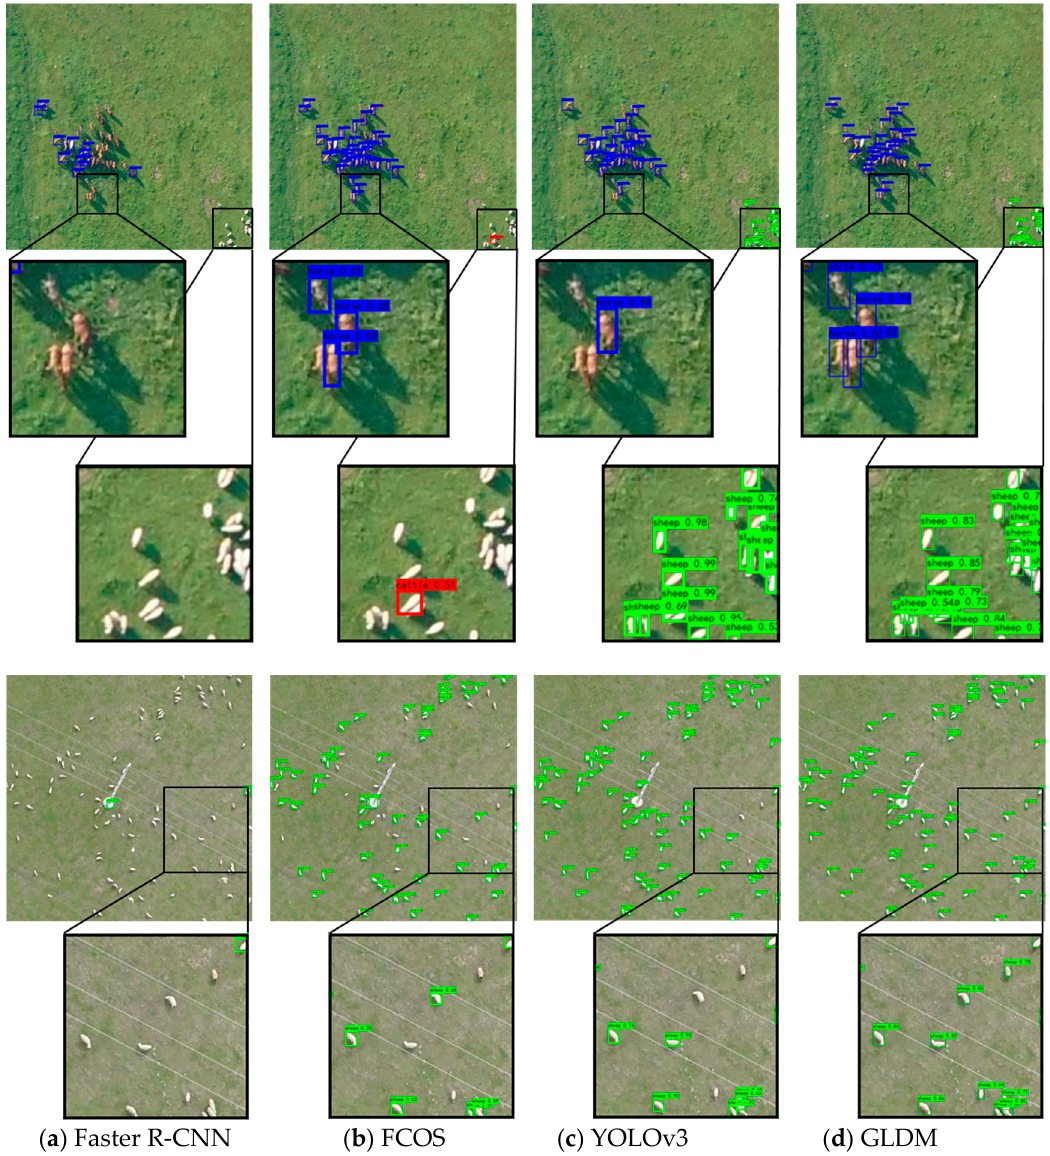
Figure 12. Visualization of the detection results for different methods. ( a ) Faster R-CNN; ( b ) FCOS; ( c ) YOLOv3; ( d ) our model (GLDM).